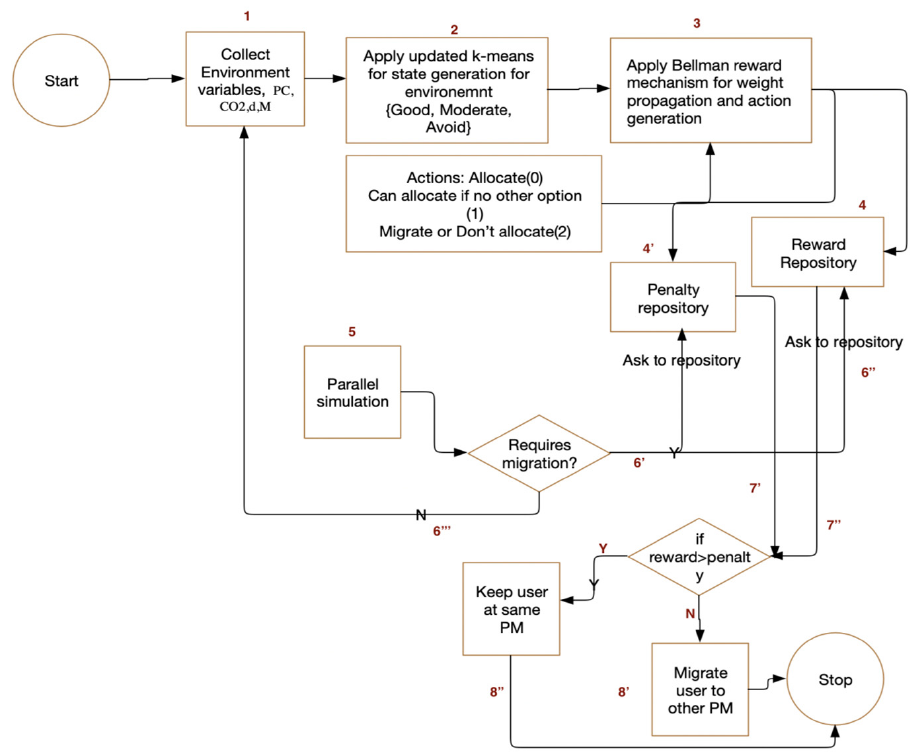
Figure 3. Proposed